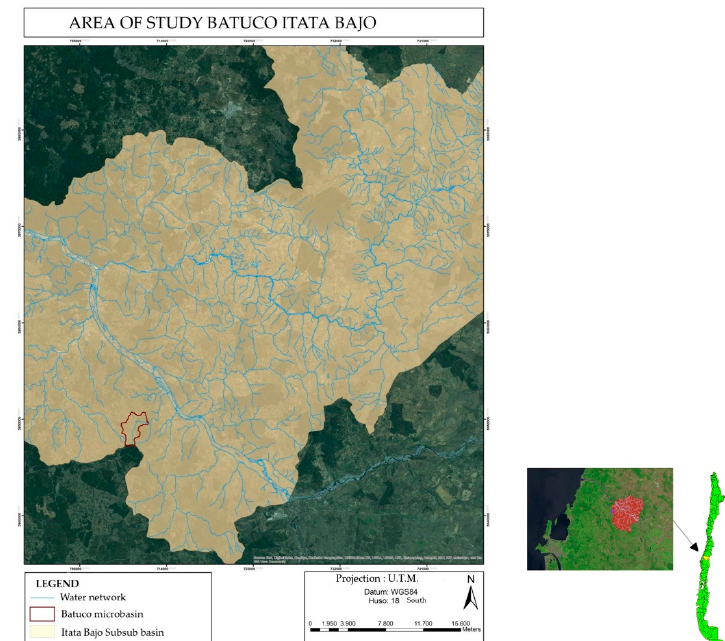
Figure 1. Location of Batuco micro-basin (red) in Itata Bajo sub-sub-basin (light brown). Source: compiled by authors of MOP [22] and www.bosquesyagua.cl.